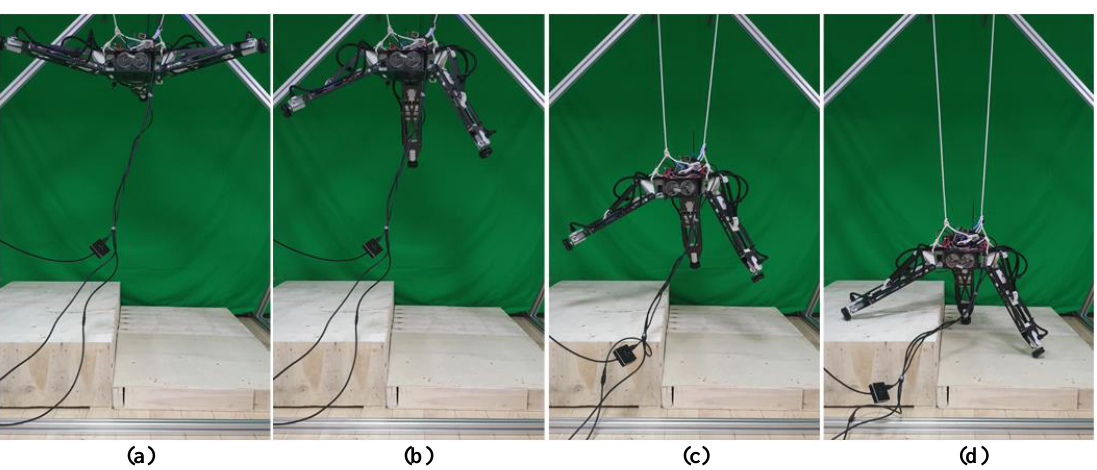
Figure 10. Flow chart of experiment data collection.